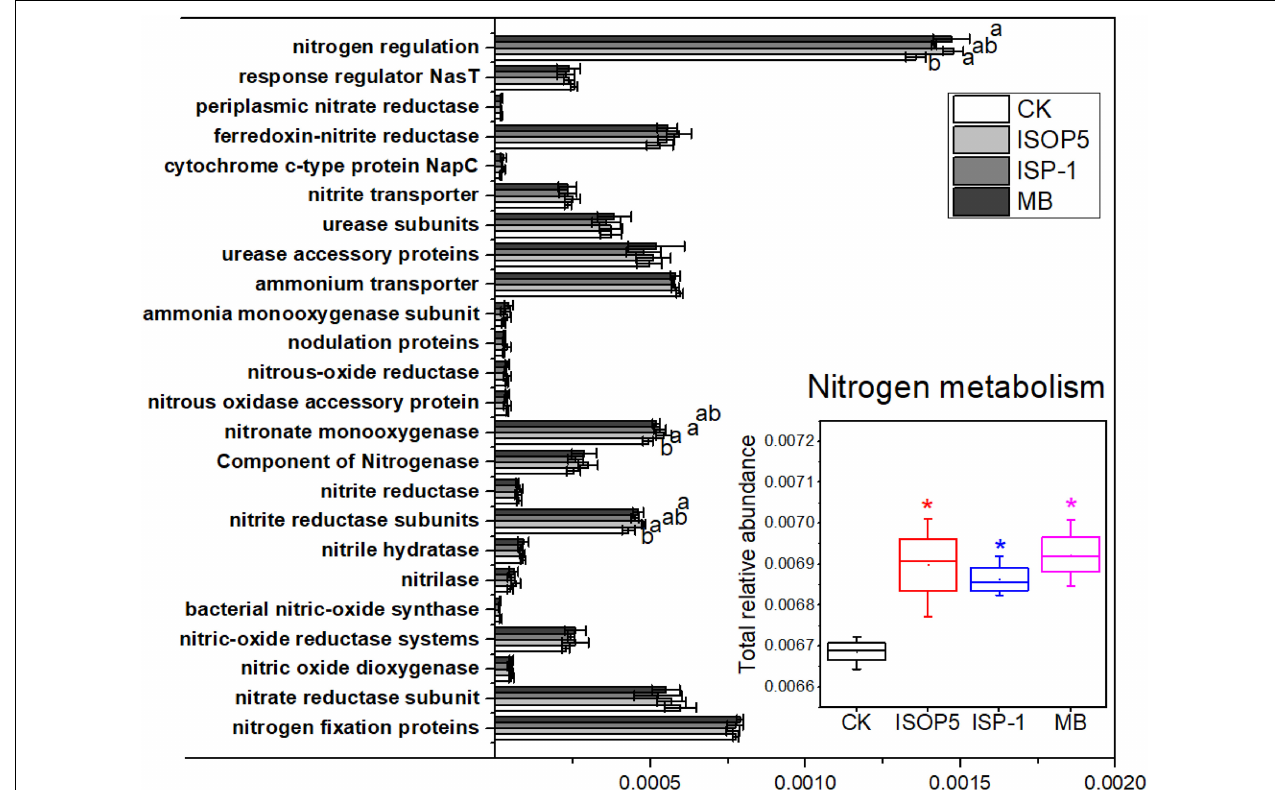
FIGURE 4 | Major functional genes involved in the N cycle and total relative abundance of genes involved in N metabolism in soils treated with or without bacterial inoculums (relative abundance > 0.001%). Different lowercase letters and asterisks represent the significant effects of bacteria inoculums on the relative abundance of genes involved in the N cycle at p < 0.05. Error bars are ± standard error. CK: fertilized with basic fertilizer containing NPK fertilizers and composted cow manure; B. cepacia ISOP5: fertilized with basic fertilizer and then applied with suspension of strain B. cepacia ISOP5; R. palustris ISP-1 : fertilized with basic fertilizer and then applied with suspension of strain R. palustris ISP-1; MB: fertilized with basic fertilizer and then applied with suspensions of B. cepacia ISOP5 and R. palustris